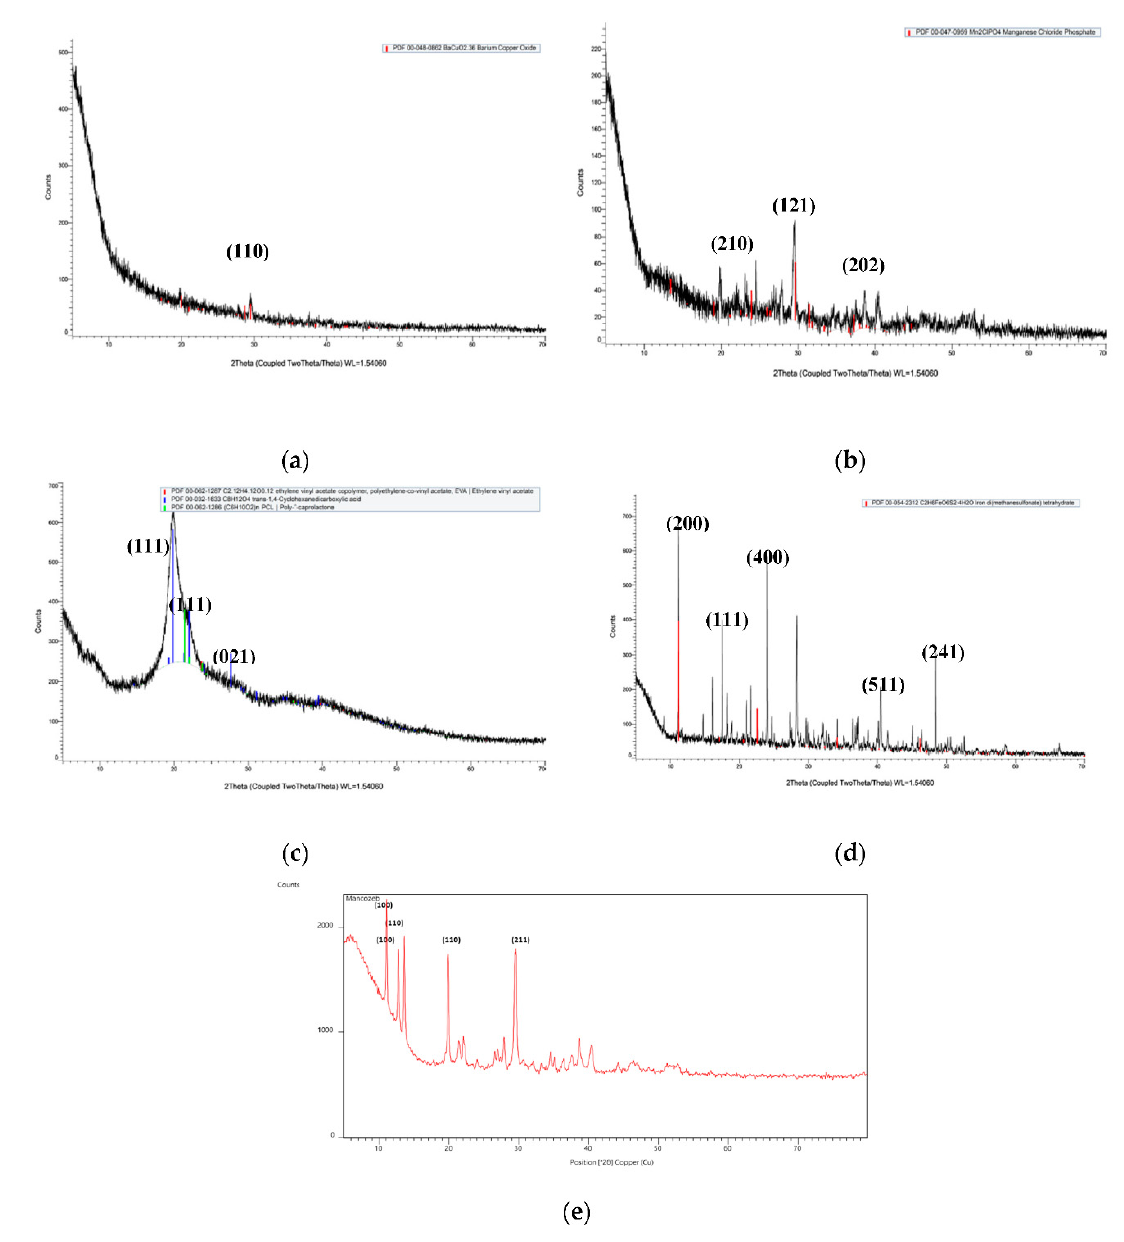
Figure 4. X-ray diffraction spectroscopy plots of ( a ) blank CSCRG nanoparticles, ( b ) mancozeb-loaded CSCRG NPs, ( c ) chitosan, ( d ) carrageenan and ( e ) mancozeb. lan gum–polyvinyl alcohol microspheres and found intense peaks at 20, 13 and 26°. In